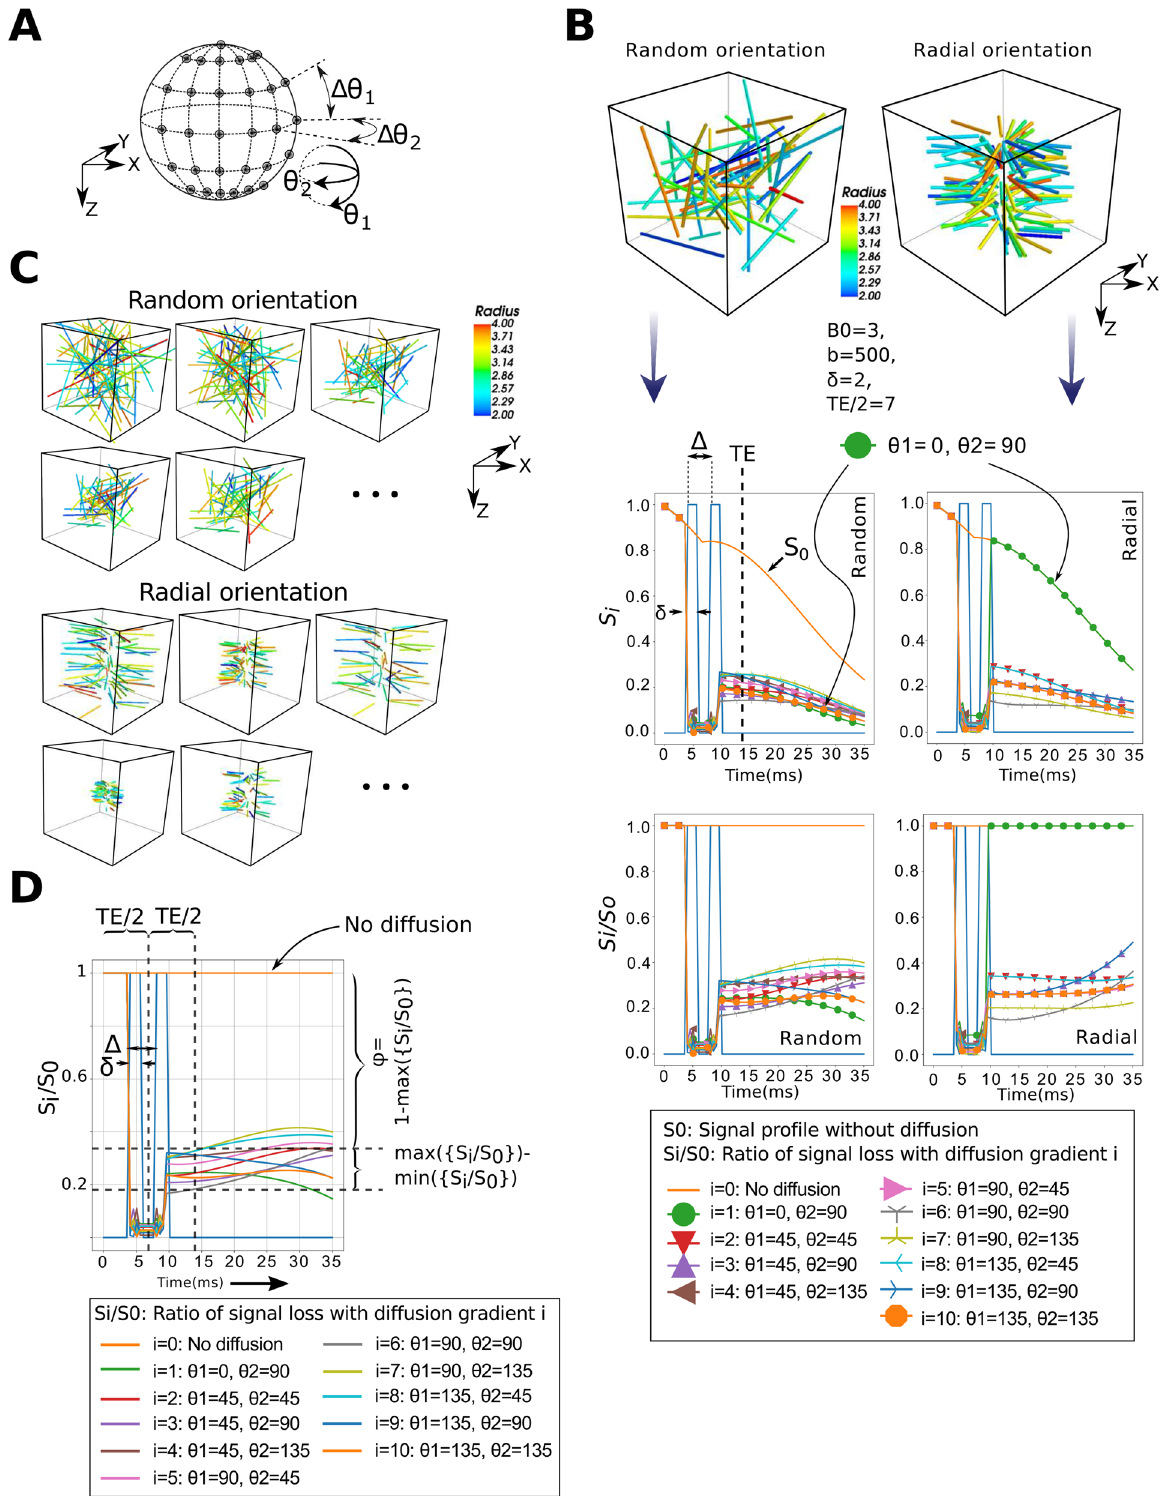
Figure 3. ( A ) A depiction of the different but isotropically distributed gradient directions used in DWI simulations. These gradients are controlled by �θ 1 and �θ 2 . ( B ) The difference between two diffusion-based MRI responses simulated-using our Monte-Carlo framework-from synthetic randomly- and radially-oriented capillary structures. For each sample, we simulate signals resulting from using different gradient directions. ( C ) Examples from the two groups in our synthetic dataset. ( D ) The quantification of signal variations after simulating the diffusion MRI responses of a vascular unit using different gradient